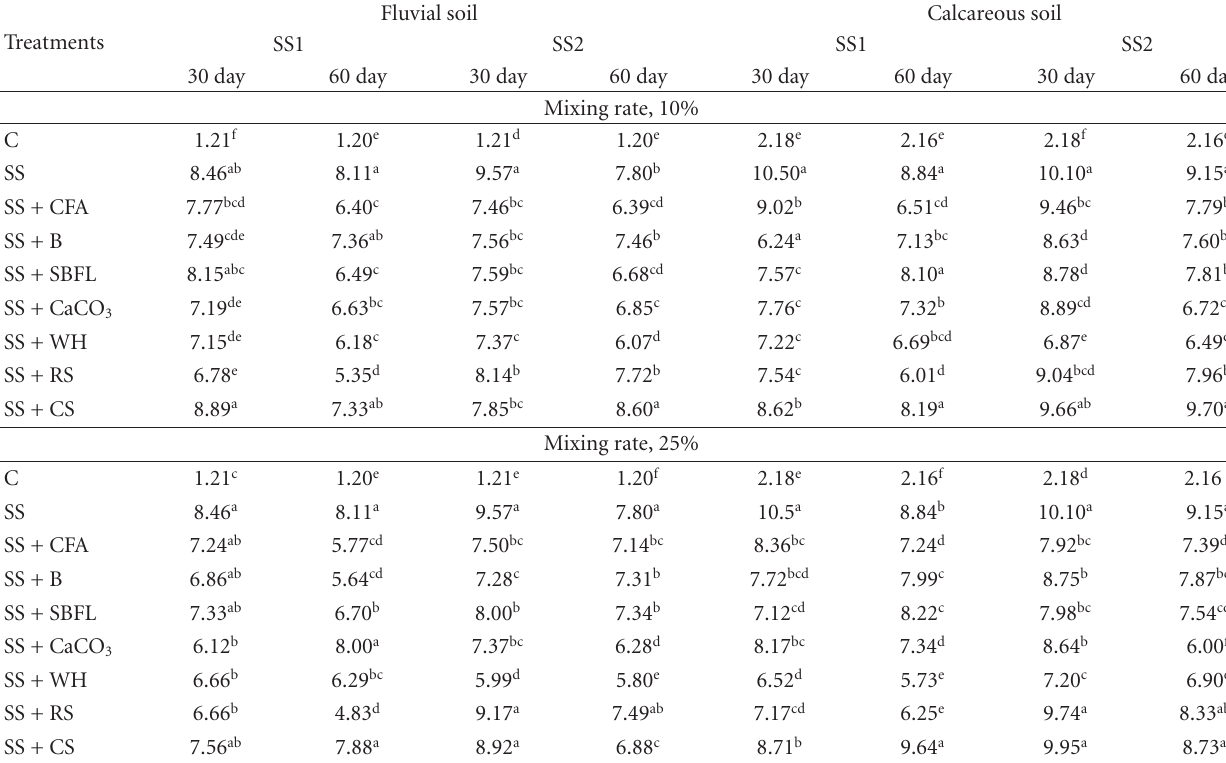
Table 6: E ff ect of sewage sludge and stabilized sewage sludge on the DTPA-extractable zinc in relation to soil type, sewage source, mixing rate, and incubation